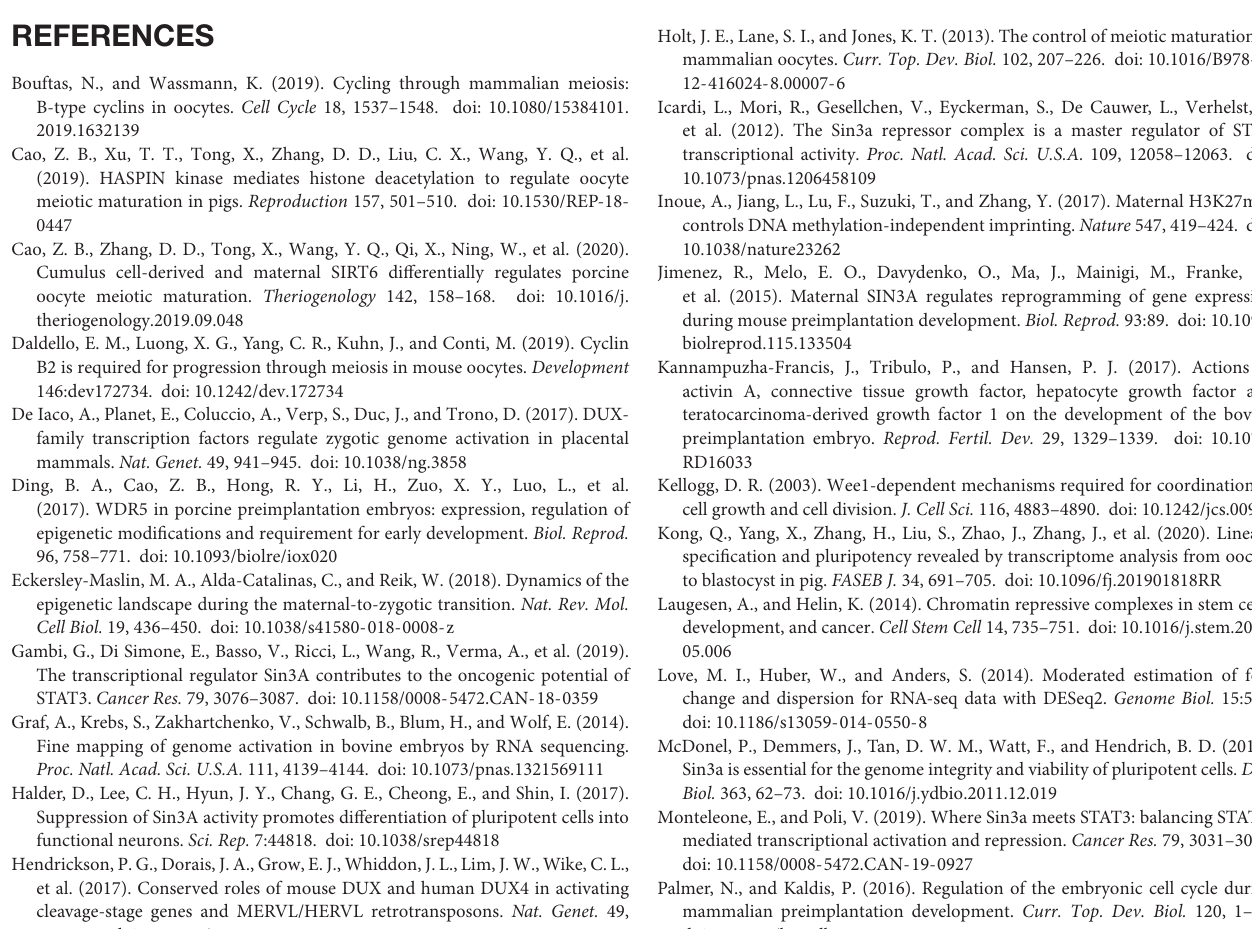
Supplementary Figure 1 | Validation of the specificity of SIN3A antibody. Mouse zygotes were microinjected of either Cas9 mRNA (control) or Sin3a mRNA, and two-cell embryos were collected and subject to immunofluorescence analysis. Scale bar = 50 µ M. Supplementary Figure 2 | HDAC1 and HDAC2 mRNA level was not changed after SIN3A knockdown as determined by